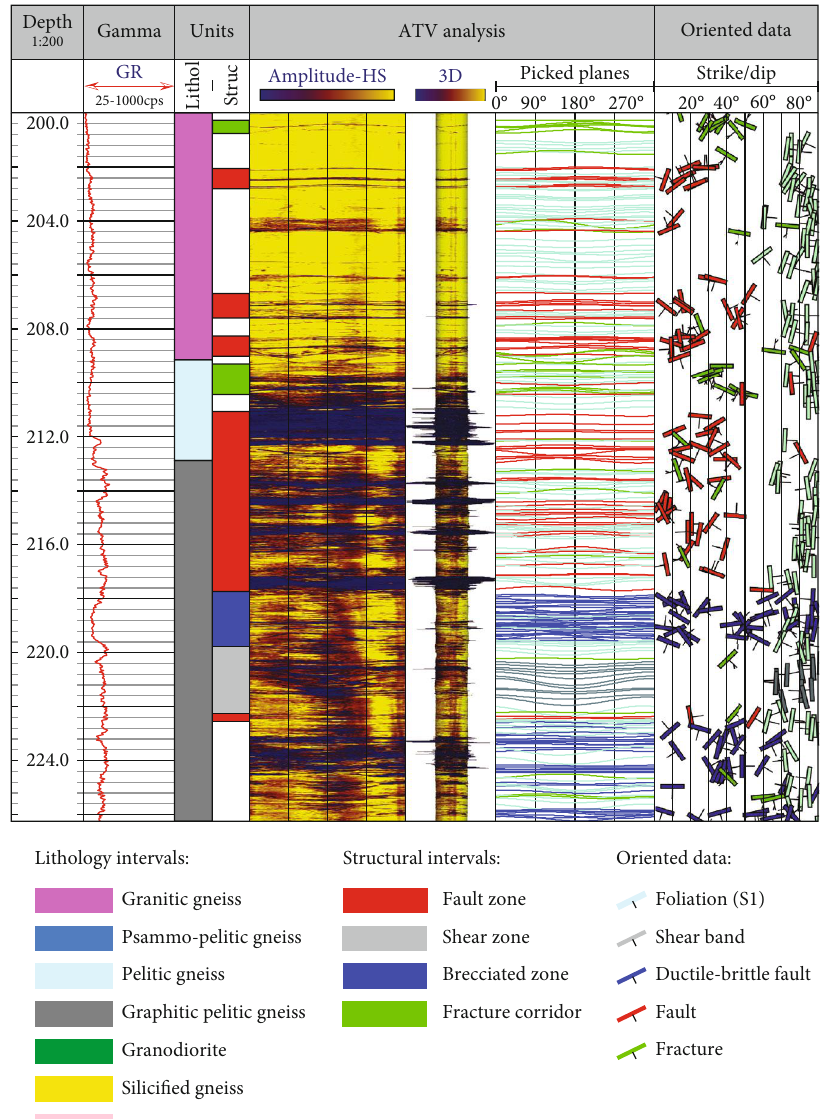
Figure 2: ATV data display as presented in this work. The “ Gamma log ” column presents the ABI GR gamma probing. The “ Litho ” column comes from Orano drill hole database (legend is on the side). The “ Struct ” column displays the interpreted intervals as indicated in the legend on the side. The Amplitude-HS and the 3D correspond to the ATV images as explained in the text. The “ Picked planes ” are the picked planes for oriented data. The “ Oriented data ” displays symbols with the measured planes with the true azimuth (north on the top of the page) on a scale of true dip from 0 (left) to 90 ° (right) (vertical line grid) of each measured plane. Each value is represented by a structural tick of which the legend is at the side. ATV from drill hole S830A. The structural features picked from ATV images providing true dip and azimuth, following [39], are illustrated in Figure